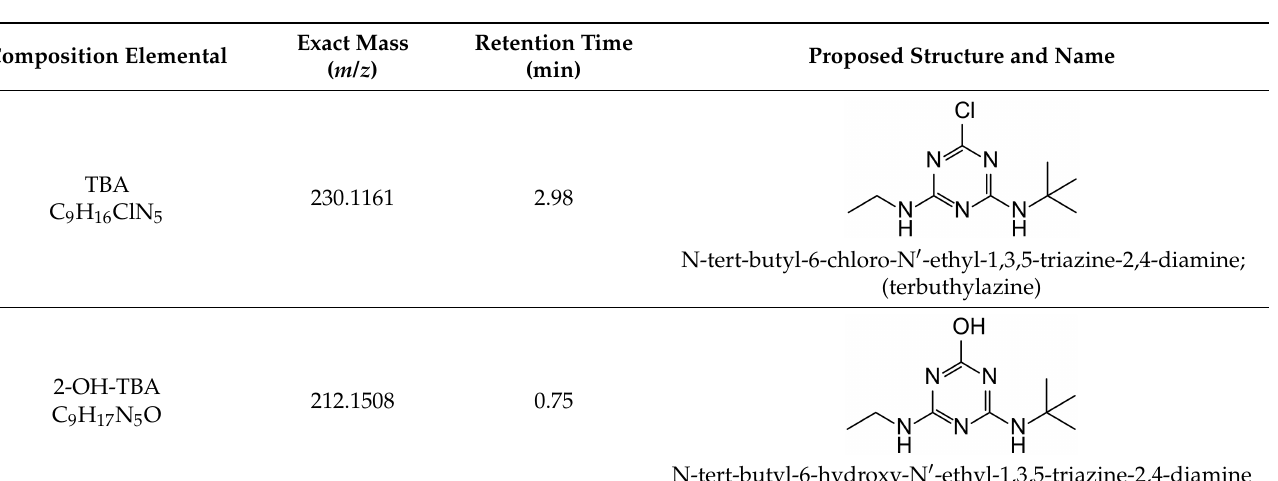
Table 6. Intermediate product detected after application of AOPs to ultrapure water in the LUZCHEM and semi-continuous